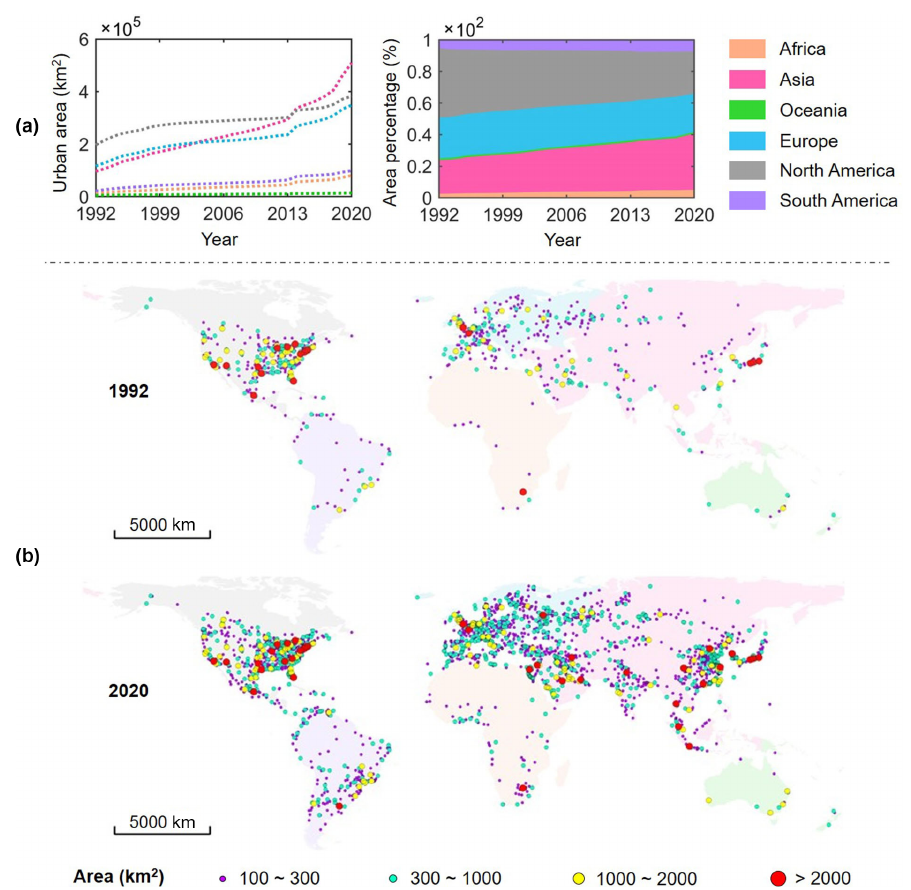
Figure 11. Dynamics of urban extents from 1992 to 2020 at the continent level (a) and the spatial pattern of urban size in potential urban clusters in 1992 and 2020 (b)